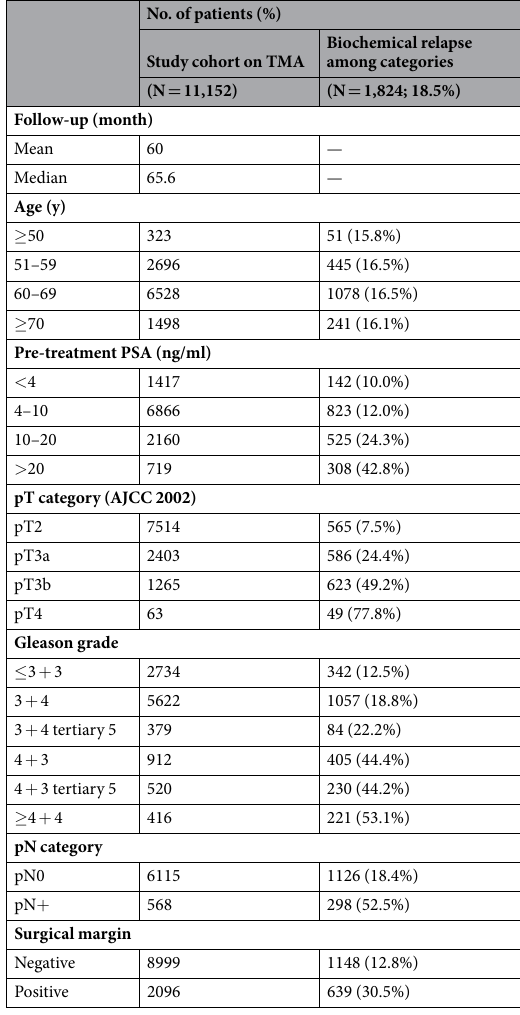
Table 2. Pathological and clinical data of the arrayed prostate cancers. NOTE: Numbers do not always add up to 11,152 in the different categories because of cases with missing data. Percentage in column “Biochemical relapse among categories” refers to the fraction of samples with biochemical relapse within each parameter in the different categories. Abbreviation: American Joint Committee on Cancer